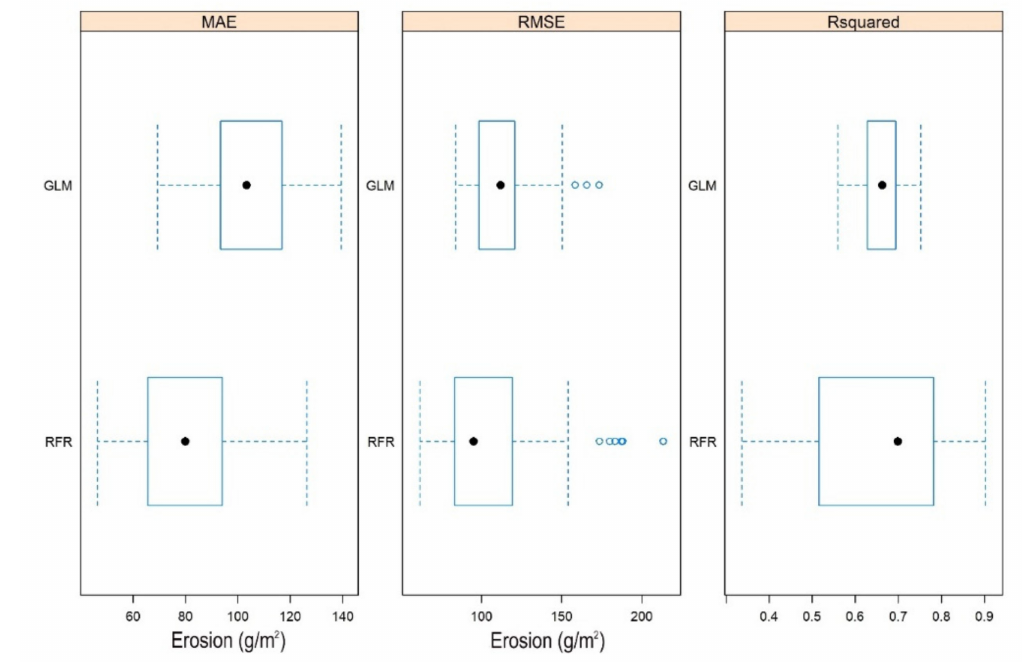
Figure 7. Range of the 50 models applied with the 2-fold cross-validation repeated 25 times ( • : median; box: interquartile range; dashed line: 1.5 times interquartile range; ◦ : outlier; MAE: mean absolute error, and RMSE: root mean square error; GLM: general linear model, RFR: random forest